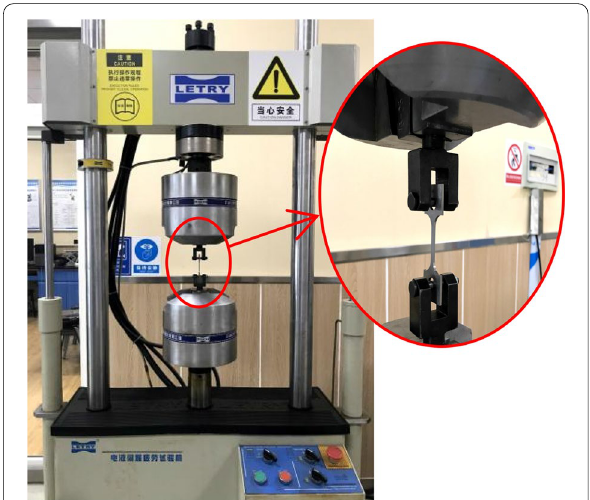
Figure 5 Sample clamping diagram for the tensile